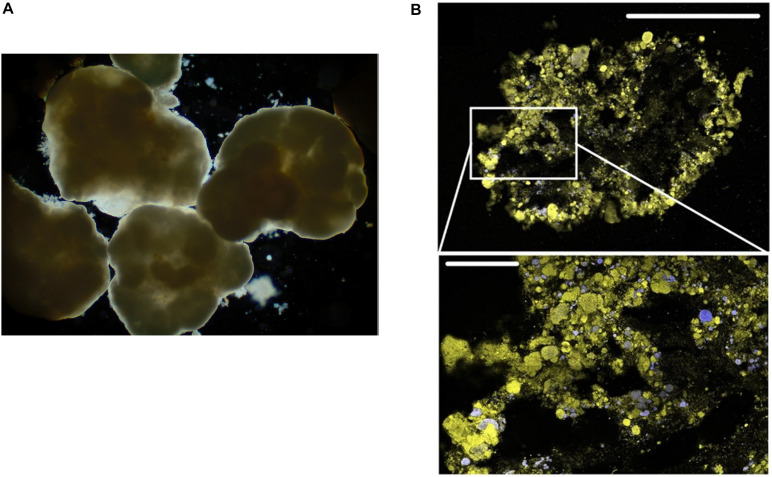
(A) Light microscopy micrograph of aerobic granular sludge (Wilén et al., 2018). (B) FISH-CLSM images from cryosections of aerobic granular sludge (upper scale bar: 500 μm) and detailed sections (lower scale bar: 100 μm). Yellow: total cells; blue: ammonia oxidising bacteria (Szabó et al., 2017). Written permissions to re-use images were obtained from journals.